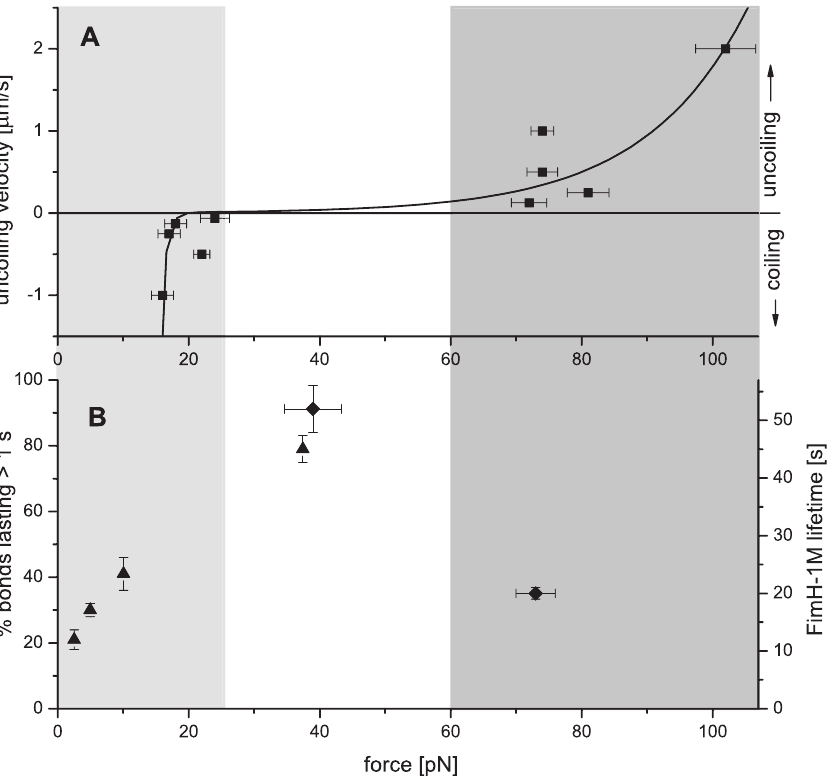
Figure 4. Comparison between the Uncoiling/Coiling Forces of the Fimbrial Shaft versus the Lifetime of the FimH–Mannose Bond (A) Uncoiling force of fimbriae as a function of pulling velocity (solid squares). Three regimes can be discerned: fimbriae uncoil significantly at forces greater than 60 pN (dark gray); they also coil back at significant velocities generating forces up to 25 pN (light gray); between 25 and 60 pN, fimbriae do not change significantly in length. A two-state model for uncoiling, assuming the coiled and uncoiled states are separated by a single energy barrier, was fit and is shown as a solid line. The model fits the data well and yields a height of the uncoiling and coiling energy barriers of 29 k b T and 4 k b T, respectively. The spring constant of the AFM cantilever for this experiment was of 6.7 pN/nm, and the data are taken from one bacterium ( n . 8 data points for each point). Other bacteria probed showed the same behavior. Similar curves were also obtained by keeping the force constant and measuring the velocity. One example is shown in Figure S1. (B) Effect of force on FimH–1M bond lifetimes. The solid diamonds (right axis) show the mean lifetimes of fimbriated FimH–1M bonds measured with the AFM by holding a constant force on fimbriae and waiting for the bonds to break. The decrease of the lifetime as force increases from 40 to 60 pN shows the weakening of the bond at high forces. The solid triangles (left axis) show the fraction of FimH–1M bonds that last longer than 1 s in flow chamber experiments ( n ¼ 4 to 6 for each point). These experiments are described in detail in Figure 5. This fraction increases from 20% to 80% between 2.5 and 38 pN, demonstrating the catch-bond nature of FimH–1M bonds. Error bars are standard error of the